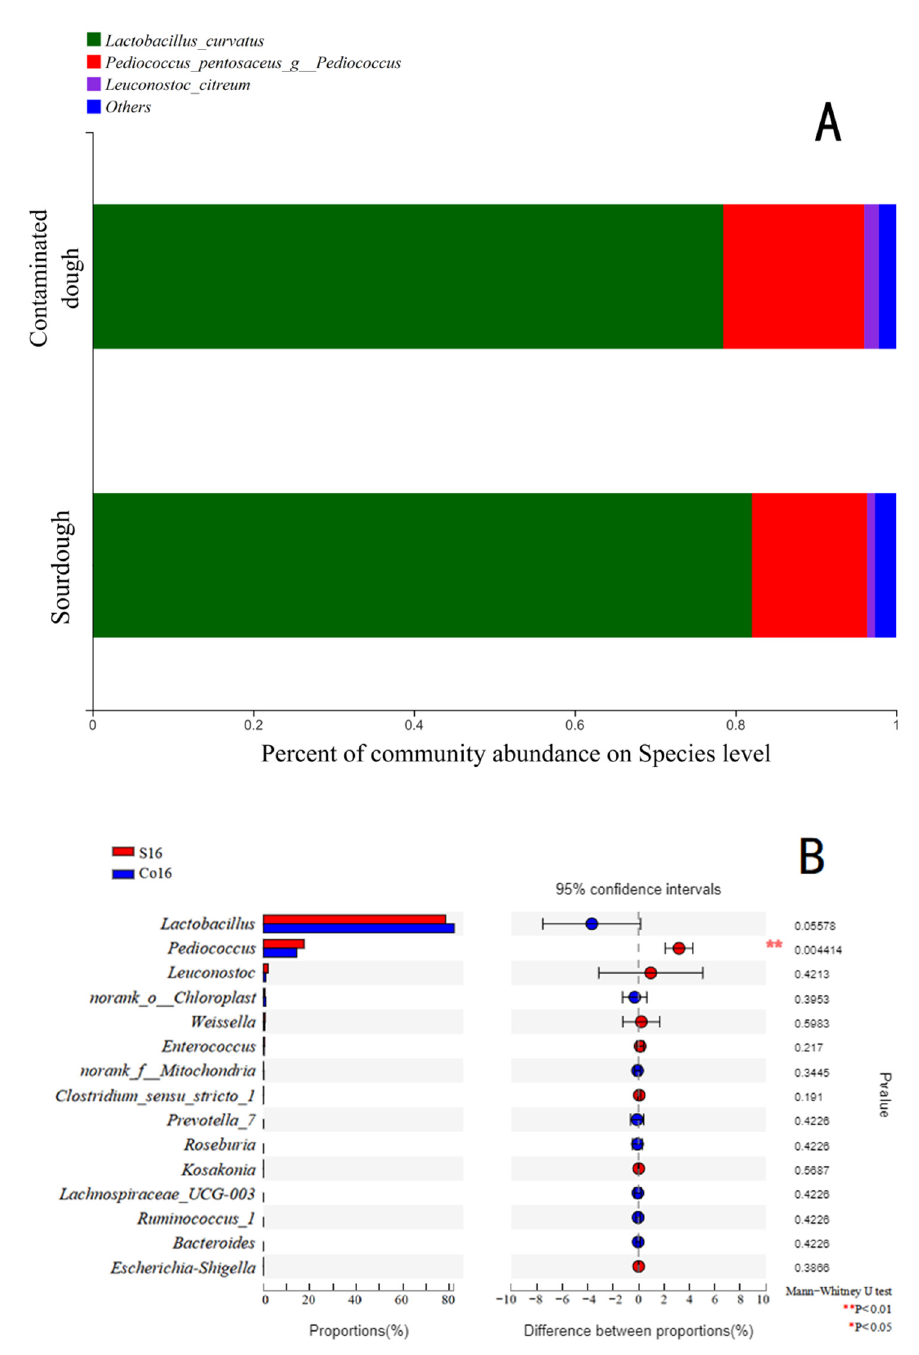
Figure 1. Bacterial composition of wholewheat sourdough ( n = 6), with Co16 indicating wholewheat sourdough fermented for 16 h and S16 indicating wholewheat sourdough artificially contaminated with S. aureus and fermented for 16 h. (( A ): Community barplot analysis; ( B ): Welch’s t -test bar plot on Genus level). Co16 indicating wholewheat sourdough fermented for 16 h. S16 indicating wholewheat sourdough artificial contaminated with S. aureus and cultured for